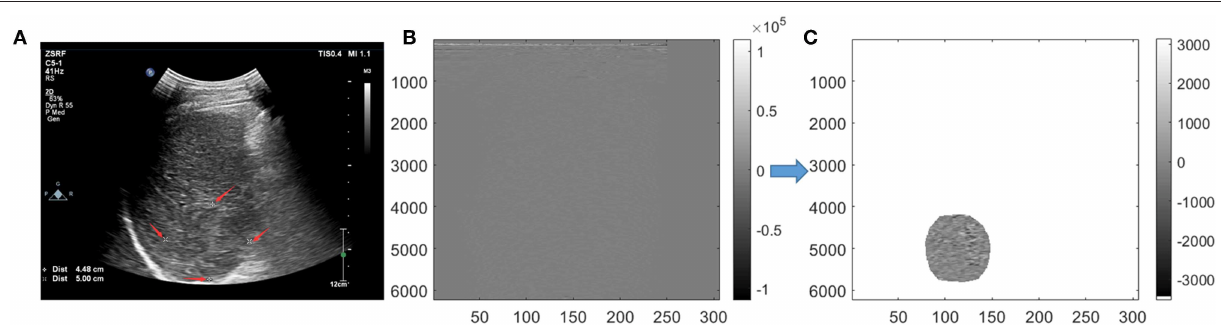
FIGURE 2 | Tumor segmentation. On grayscale ultrasound image, the region of interest (ROI) was manually marked by a doctor with four white forks points (A) . Image were segmented in scan-line imaging way for original radio frequency (ORF) data (B) . After Hilbert transform and logarithmic compression of ORF signals, the grayscale ultrasound images under the scan-line images could be obtained (C)